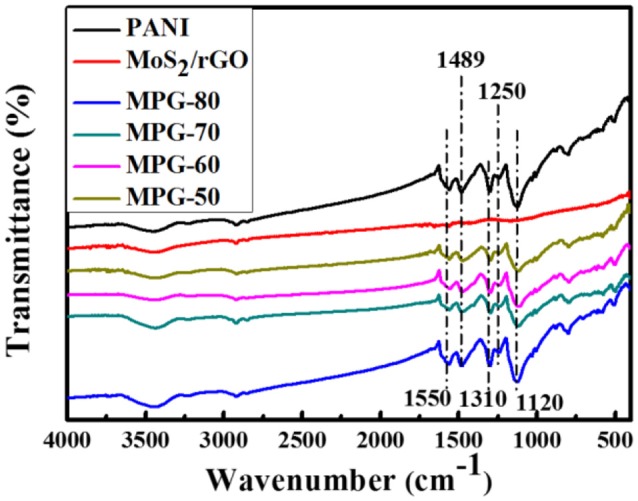
FT-IR spectra of the PANI, MoS2/rGO binary composite, and MoS2/rGO/PANI ternary composites.